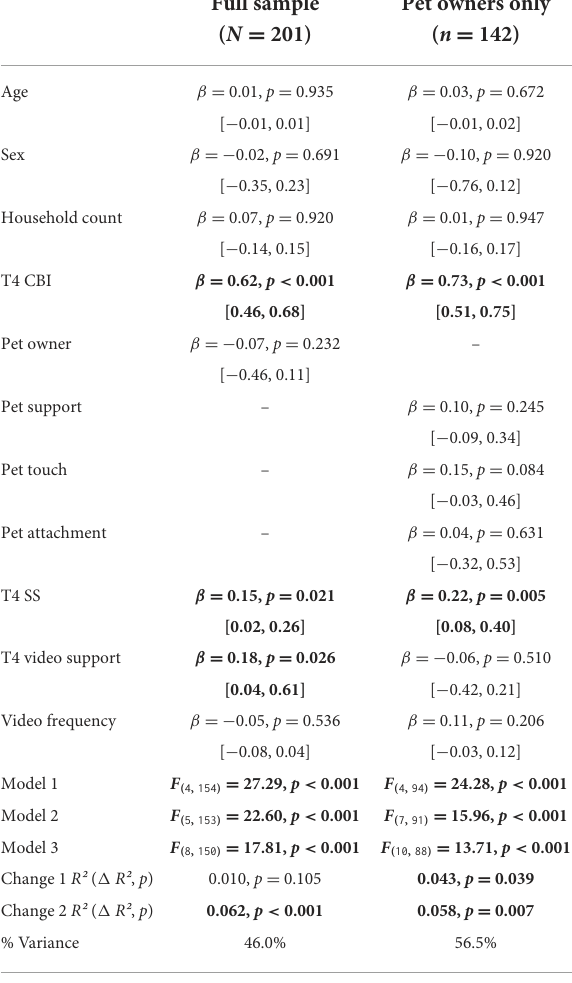
TABLE 4 Social support hierarchical regression results. TABLE 5 Coping strategies hierarchical regression